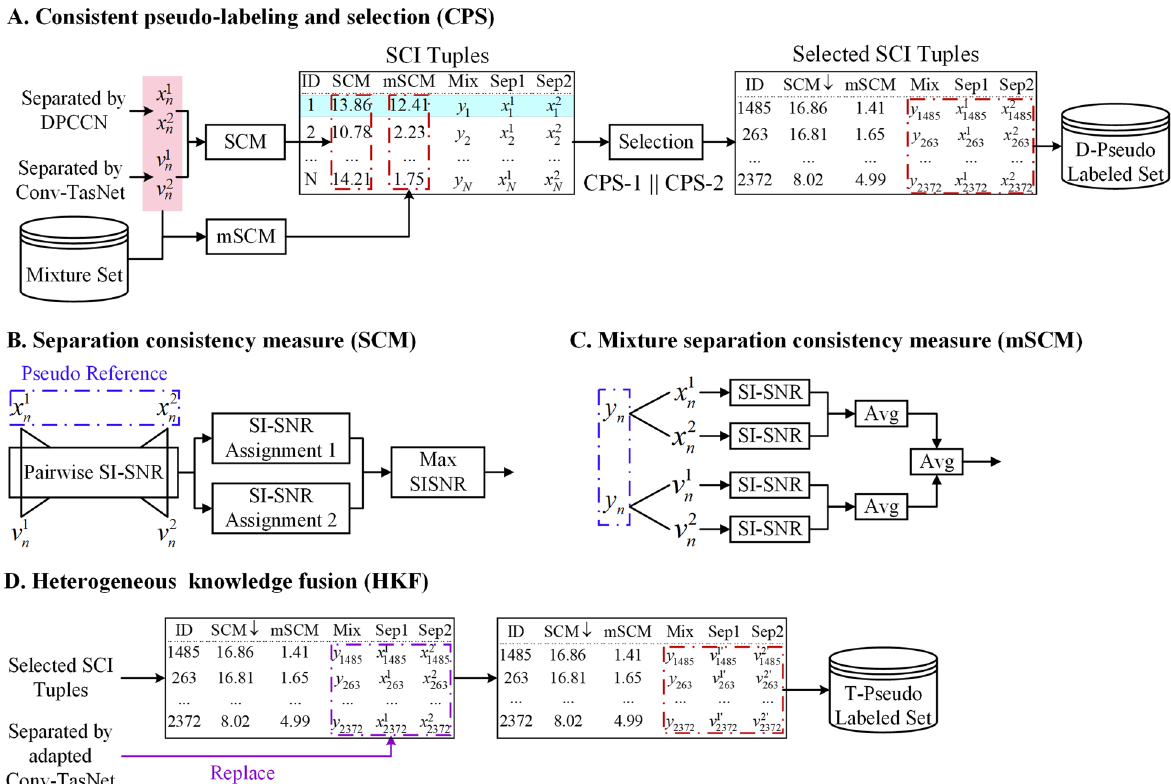
Fig. 2 A The whole framework of consistent pseudo-labeling and selection (CPS). B The flowchart of separation consistency measure. C The flowchart of the mixture separation consistency measure. D The heterogeneous knowledge